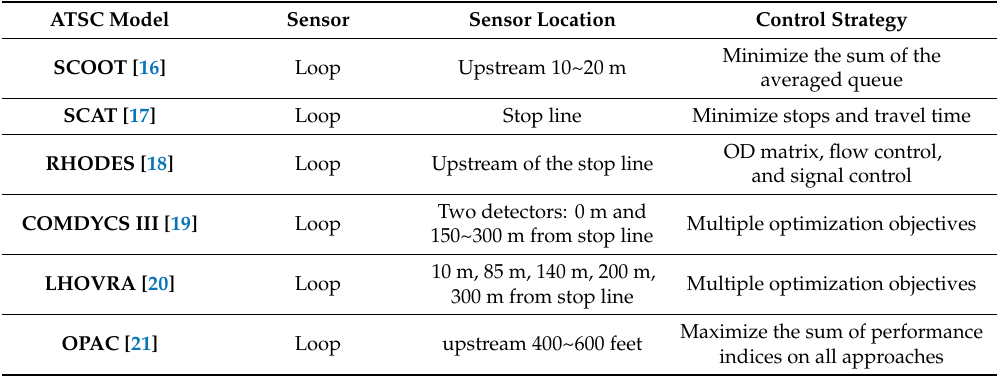
Table 1. Adaptive tra ffi c signal control models.